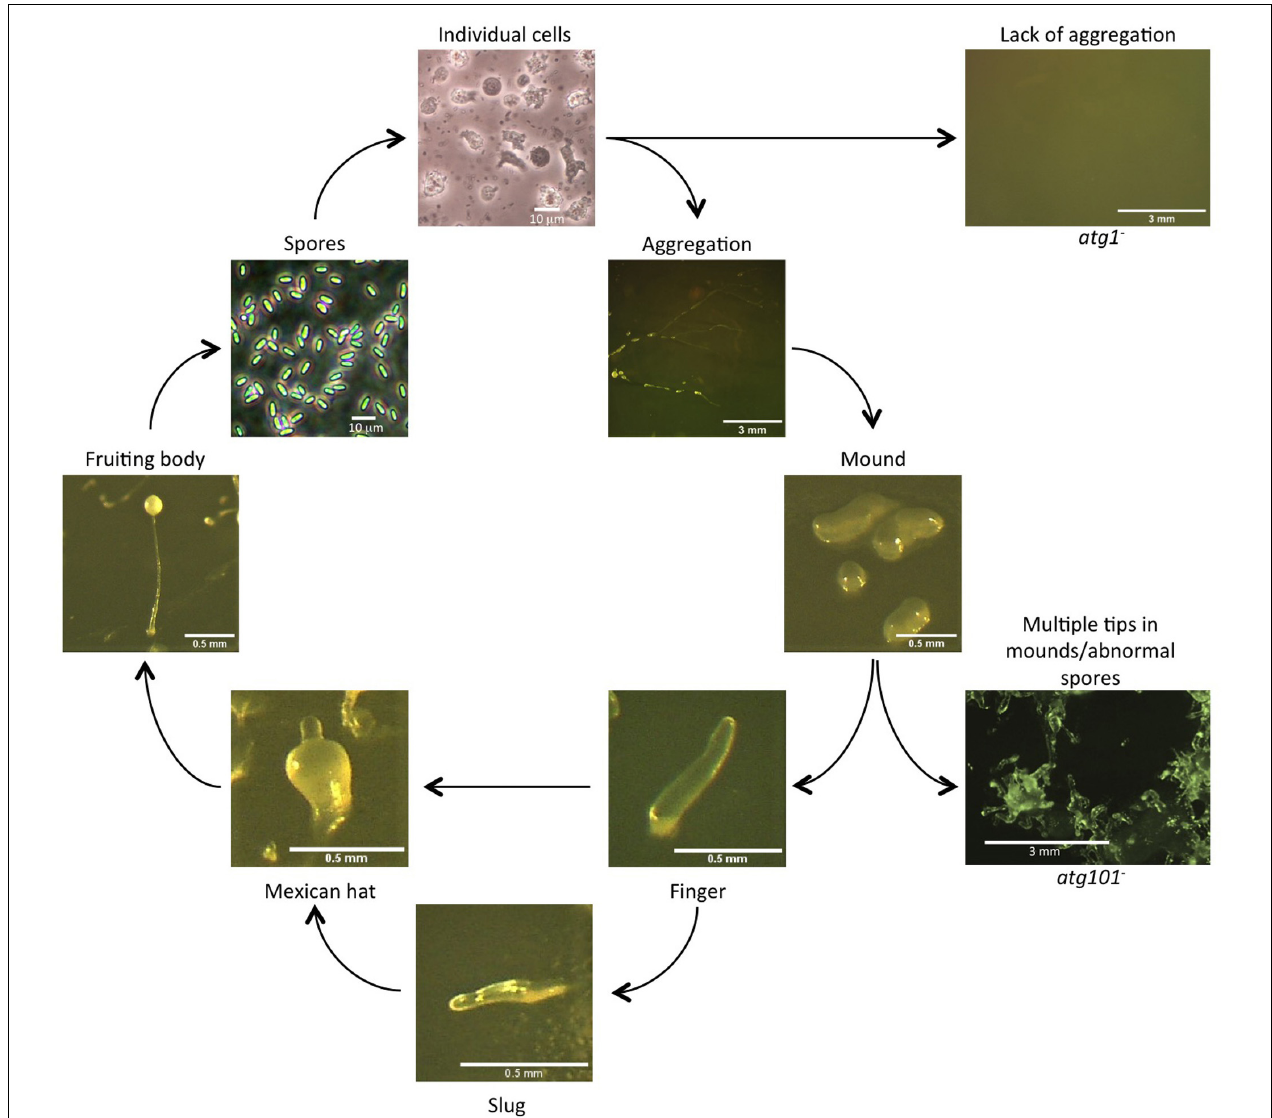
FIGURE 2 | Autophagy is required for Dictyostelium development. Representative pictures of the Dictyostelium life cycle are shown. Strains defective in autophagy (right panels) show distinct phenotypes, such as lack of aggregation (Atg1 mutant is shown as an example) or abnormal development with a lack of spores (Atg101 mutant is shown as an example). Scale bars are shown in each